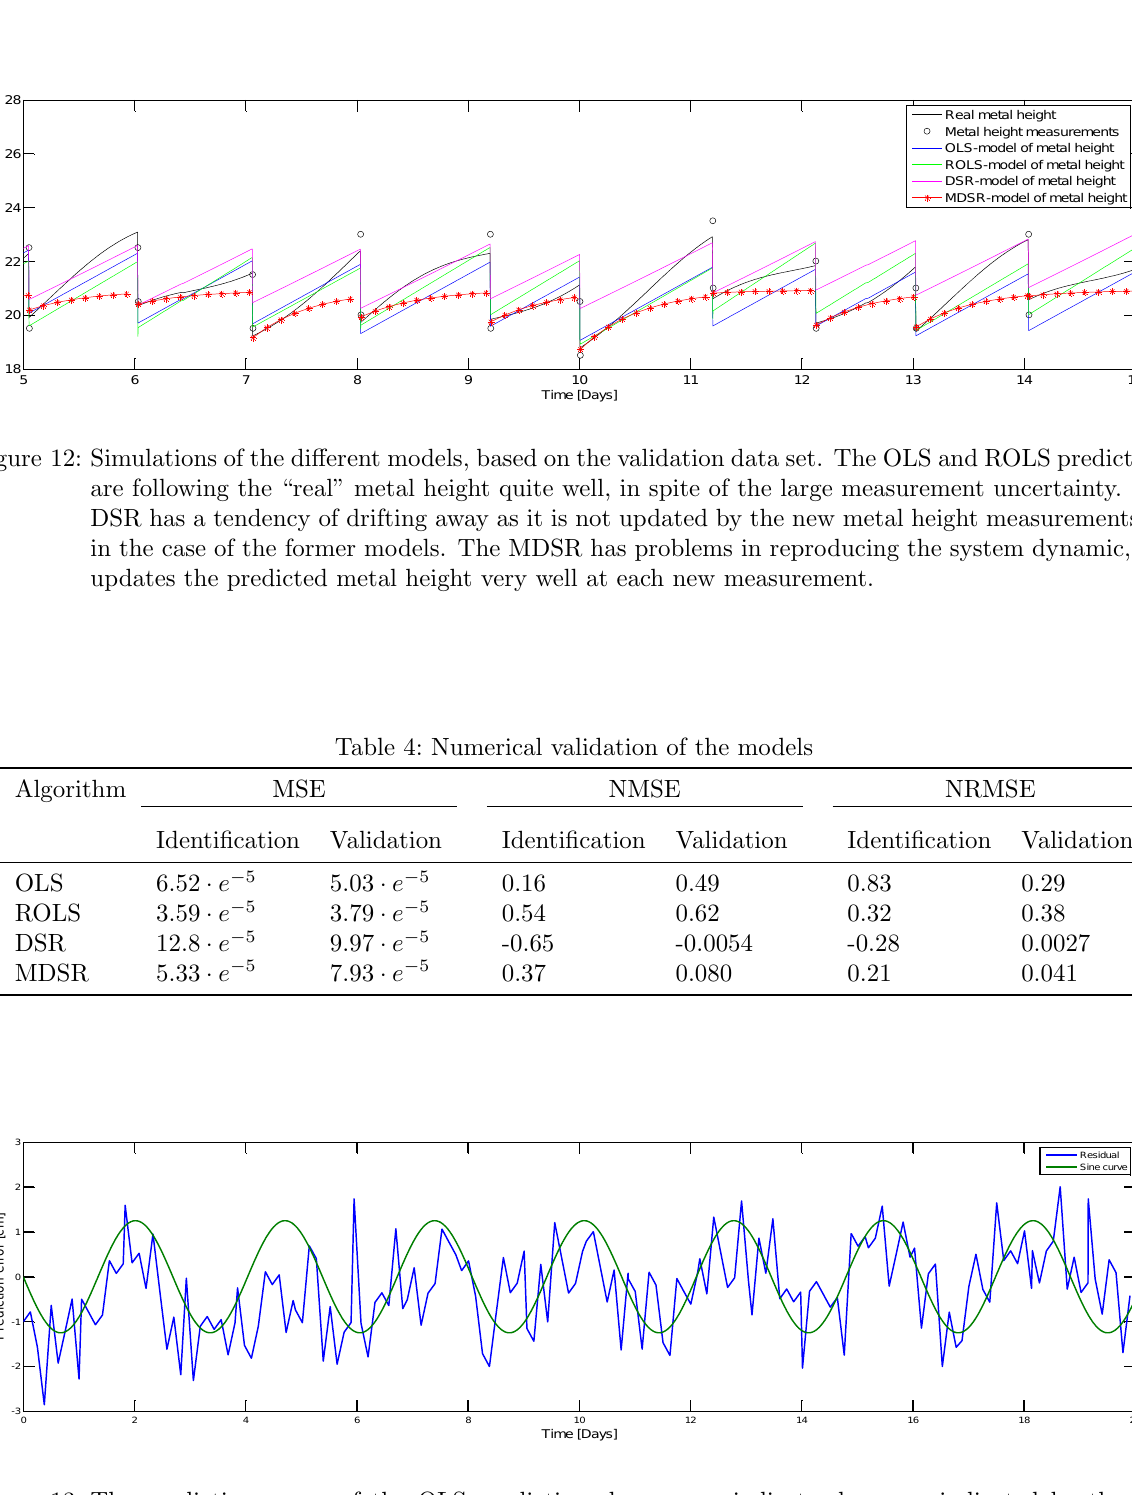
Figure 13: The prediction errors of the OLS prediction shows a periodic tendency as indicated by the sine function plotted with identical periodicity of the not measured input variable “Cross section area”. This indicate that there are dynamics in the data set not identified by the OLS model. This is related to a “lurking”variable, that is not included in the data set used for